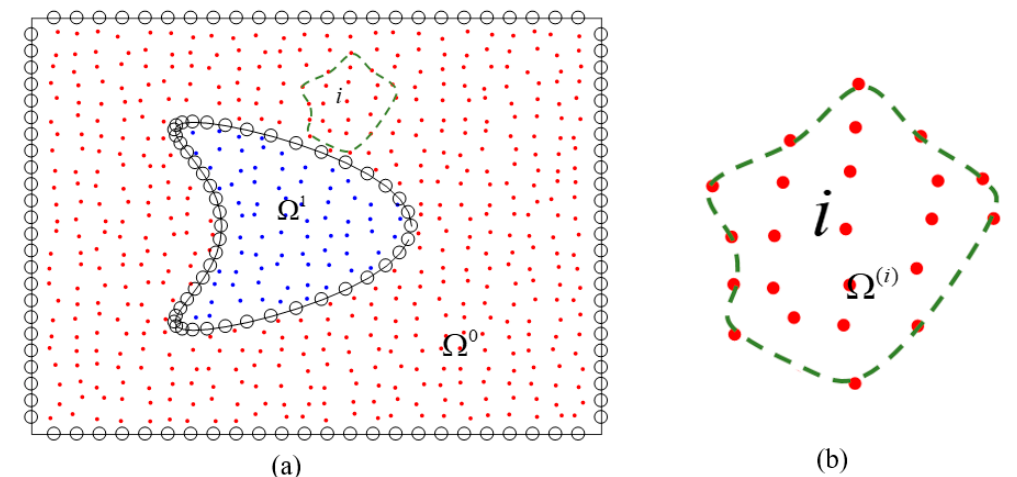
Figure 3. The schematic diagram for ( a ) the computational domain, boundary, and distribution of nodes; ( b ) The subdomain of the i th node.